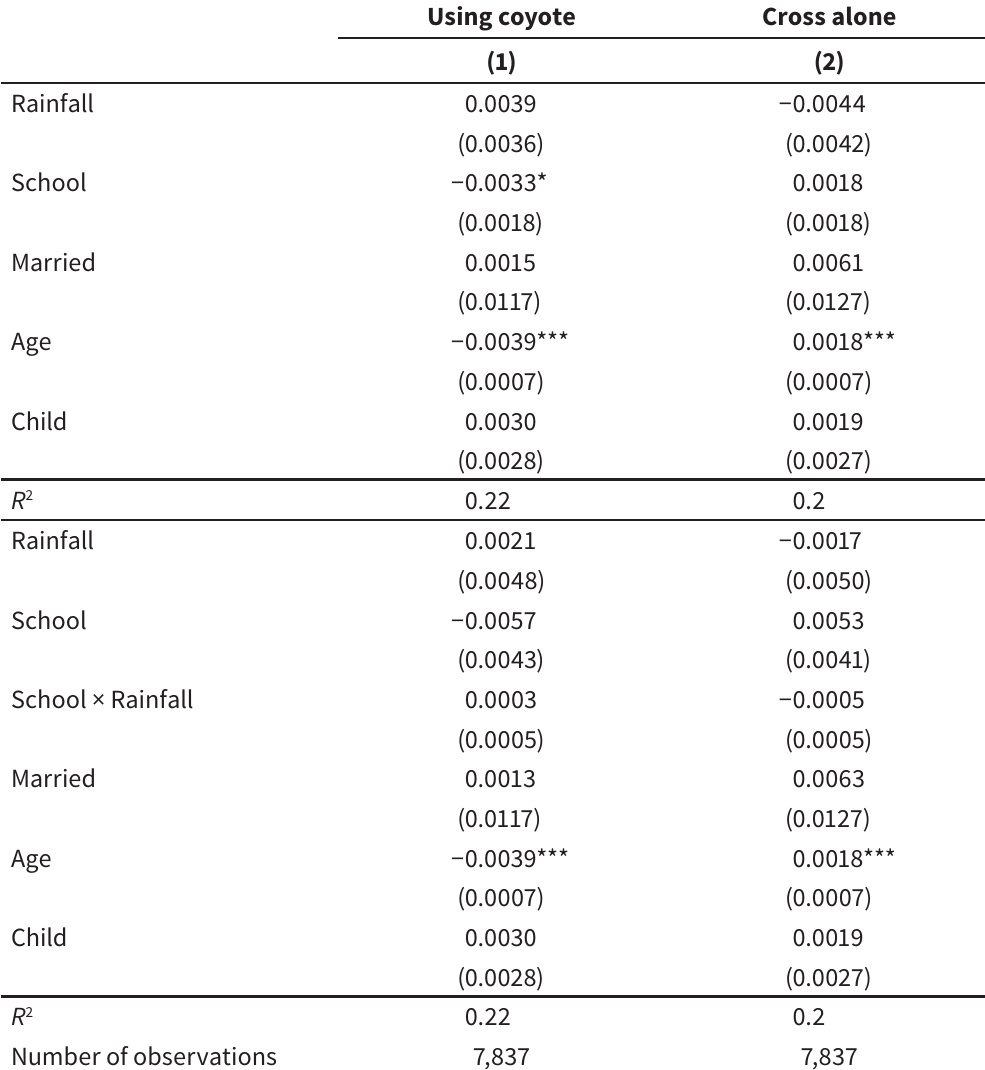
Relationship between rainfall and illegal migration